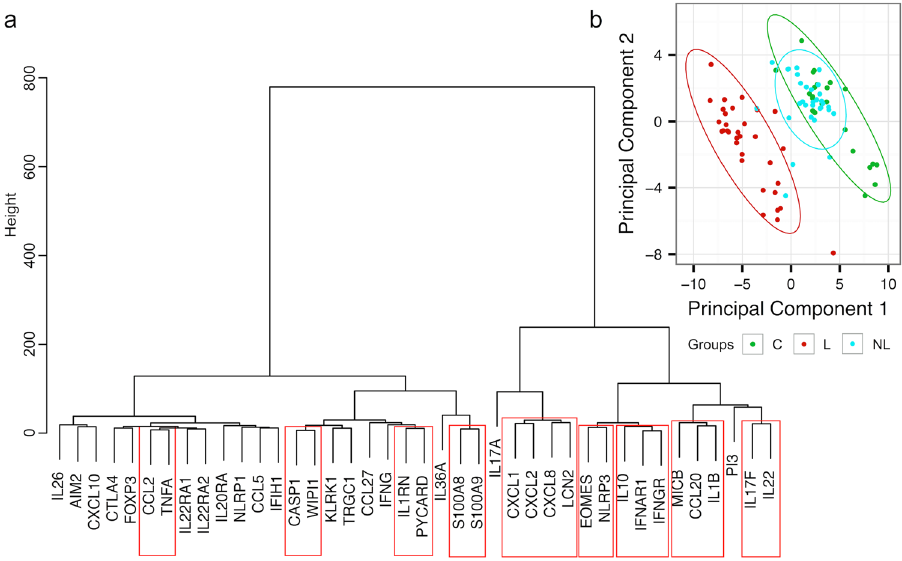
Figure 4. Hierarchical clustering and PCA of gene expression data. ( a ) Euclidian distance and ward linkage were used as parameters to cluster gene expression profiles. Strong clusters (depicted with boxes around gene names) were selected with pvclust. ( b ) PCA of gene expression data from biopsy samples derived from lesional (L) and non-lesional (NL) skin of psoriasis patients and from age-matched control individuals